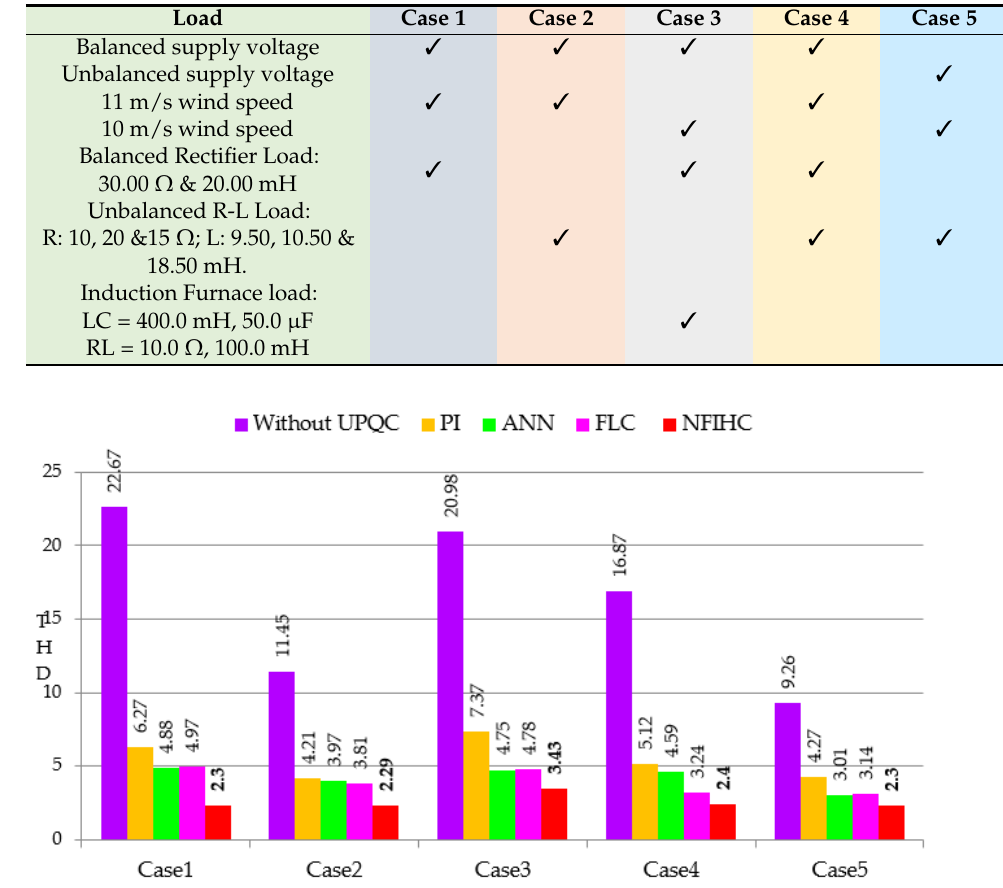
Table 5. Case studies considered.